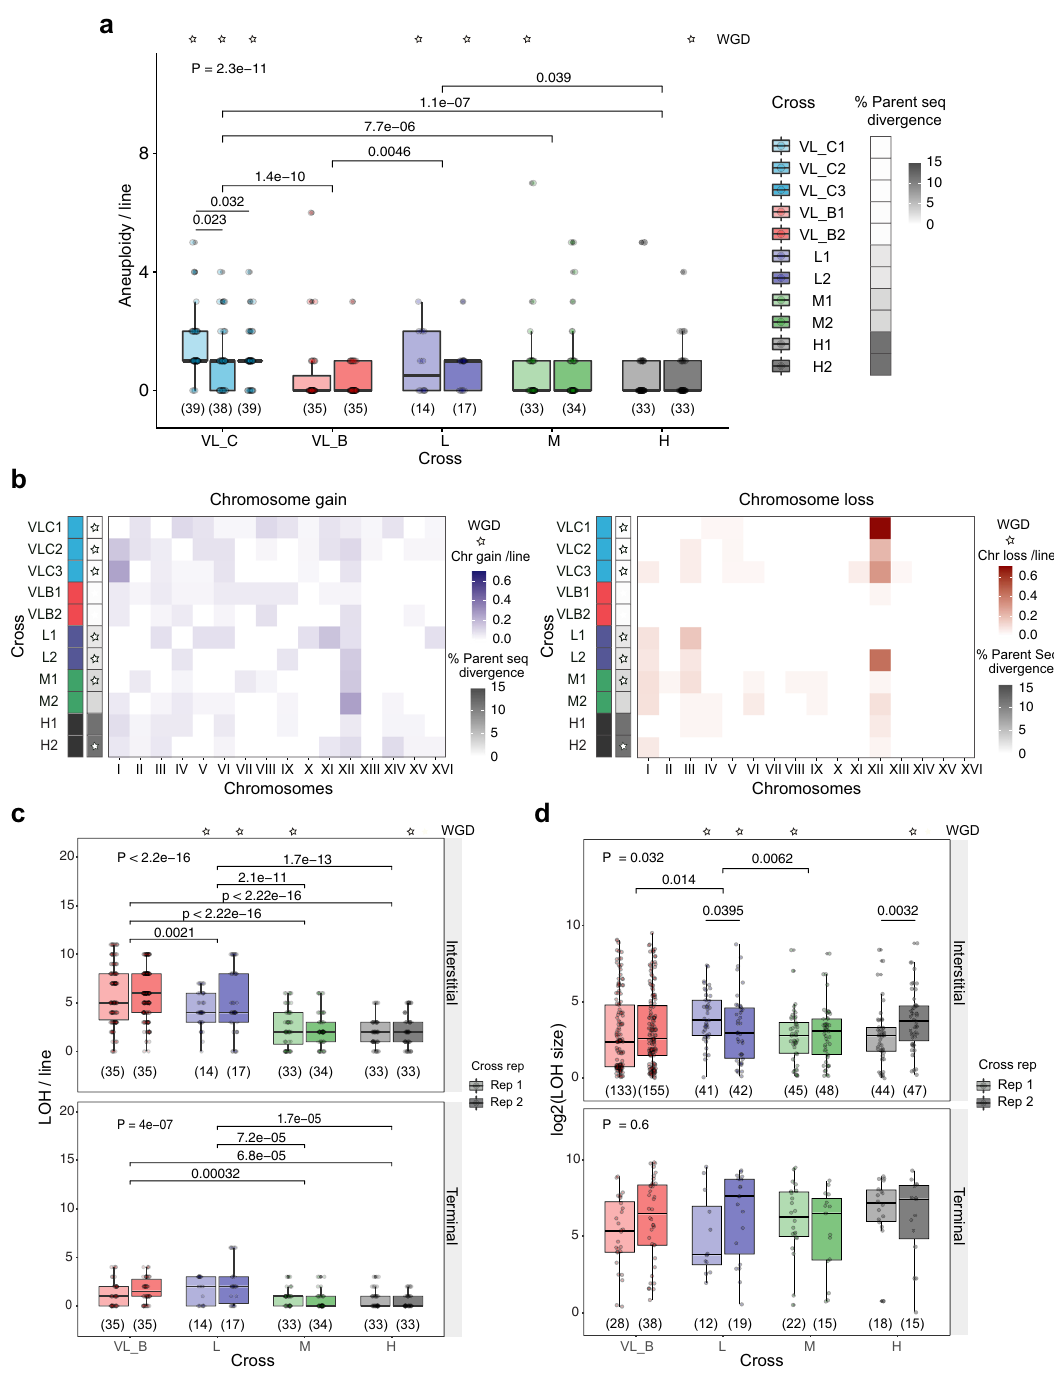
Fig. 3 Higher rate of whole-genome duplication correlates with higher genomic instability. a Aneuploidy rate among diploid intra-lineage crosses and hybrids. b Different patterns in chromosome gain (left panel) and loss (right panel) in diploid intra-lineage crosses and hybrids. c Loss of heterozygosity (LOH) rate in diploid intra-lineage crosses and hybrids decreases with genetic divergence ( P < 2.2e − 16 for interstitial LOH and P = 4e − 7 for terminal LOH, Kruskal Wallis test). d Interstitial and terminal LOH segments size in diploid intra-lineage crosses and hybrids. The crosses with a star are those where whole-genome duplication (WGD) occurred. Numbers in parentheses represent the number of biologically independent lines ( a and c ) or independent LOH segments ( d ). P values from the Kruskal Wallis test (above) and a pairwise two-sided Mann – Whitney – Wilcoxon test are shown (only P values <0.05 are shown). For all boxplots the bold center line corresponds to the median value, the box boundaries correspond to the 25th and the 75th percentile, the whiskers correspond to 1.5 times the interquartile range, minimum and maximum values correspond to the minima and maxima and the dots correspond to the individual data